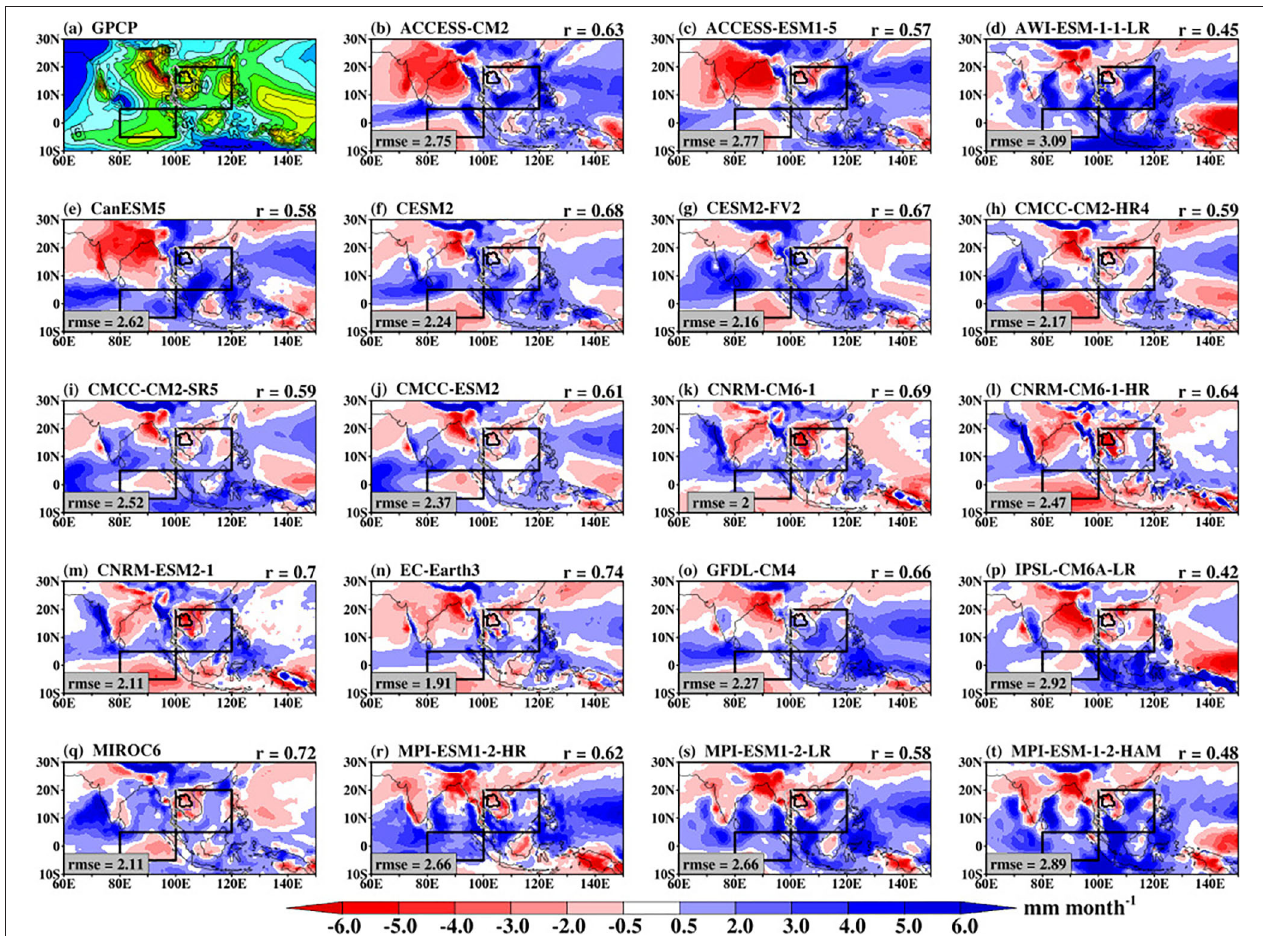
FIGURE 13 | The bias in the simulated monthly mean rainfall (b–t) with reference to GPCP (a) during May–October 1997–2014. The mean pattern of GPCP rainfall is indicated for reference. The pattern correlation (r) and the root mean squared error (rmse) values between the simulated patterns and that of GPCP in Supplementary Figure 1 are indicated for